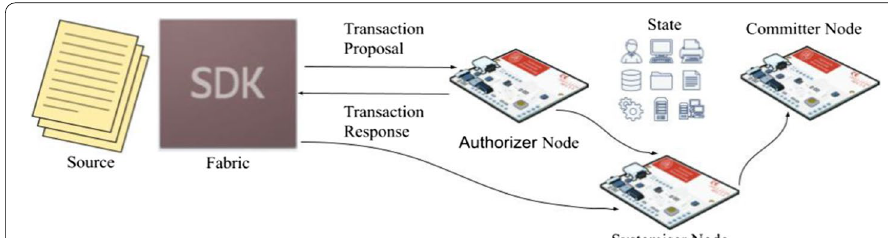
Fig. 2 Basic transaction flow (Hyperledger Fabric). For proposed scheme Hyperledger Fabric modular architecture (Figure) was applied for Blockchain execution. It contributed as exclusive methodology to consensus that permitted a highly modular and efficient (i.e., low latency) permissioned architecture while maintaining privacy. Fabric consists of source, peer, systemiser, and service provider. Service provider manages stakeholder ID and authenticate service users to permit access to the network in which transactions were programmed as per shared ledger in pre-specified regular